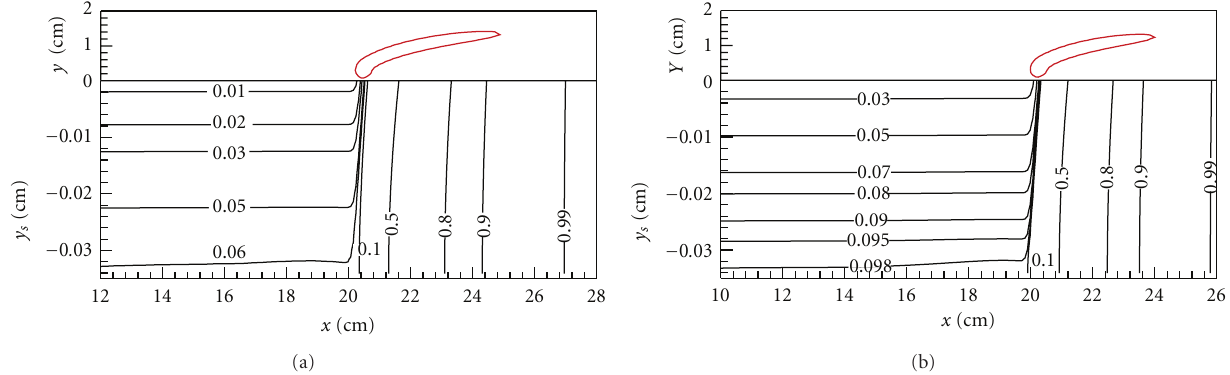
Figure 6: Solid leftover occurs when flames are near the extinction limit. (a) X O2, ∞ = 16% (b) X O2, ∞ = 15%. Upper plane: indication of visible flame shape. Lower plane: solid residual fuel percentage. (contours of ρ s , F /ρ s , F 0 ). Ordinate scales are di ff erent in y (gas-phase) and y s (solid phase).